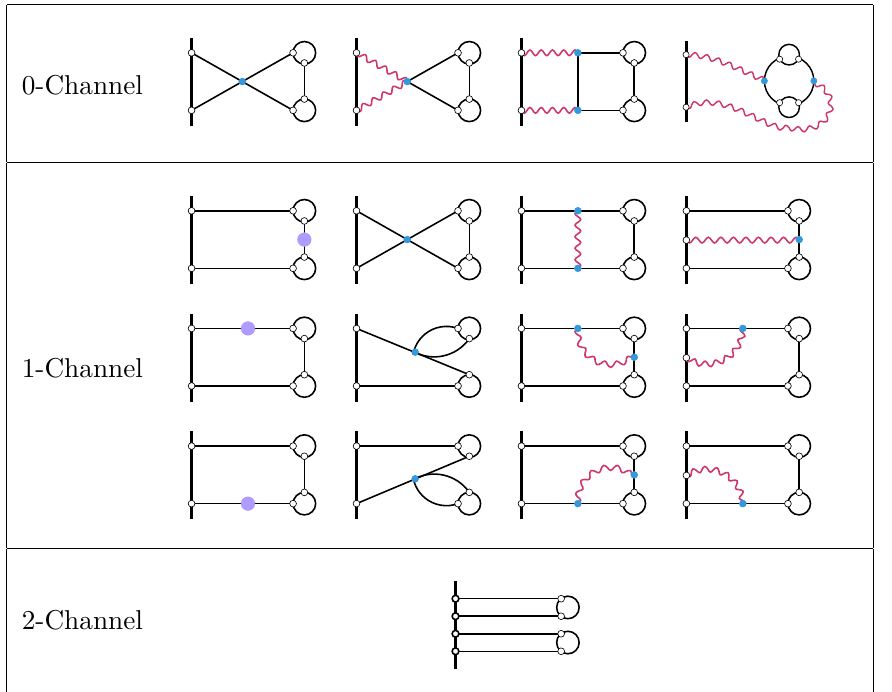
Table 1. Feynman diagrams in the planar limit N → ∞ for the computation of the two-point function with line defect at next-to-leading order (NLO). The configurations are classified in function of their R-symmetry channel. It should be understood that all (planar) path orderings on the Wilson line have to be considered for each